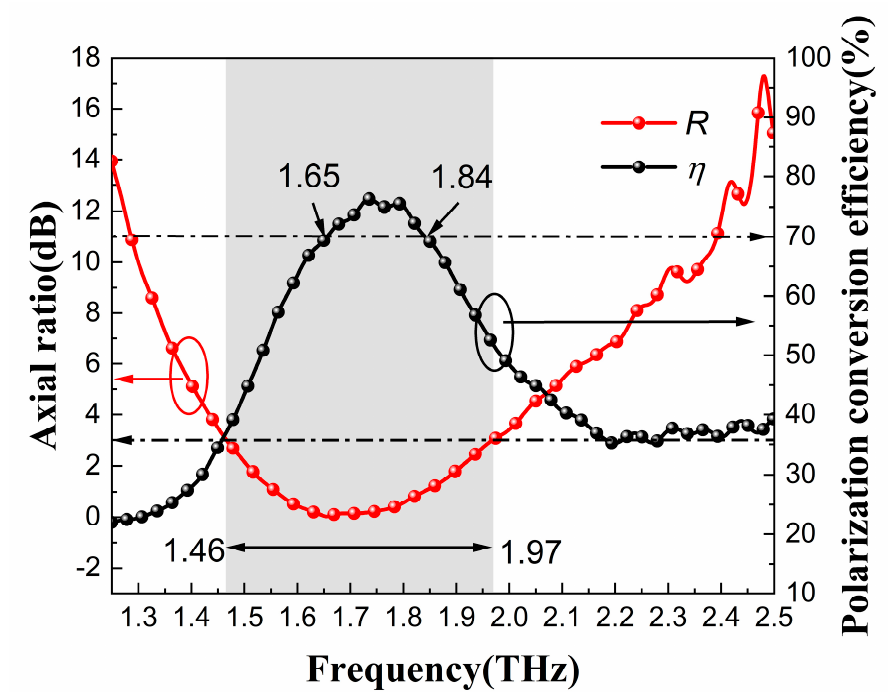
Figure 5. The axial ratio and polarization conversion efficiency of the QWP at an incidence angle of 0°.